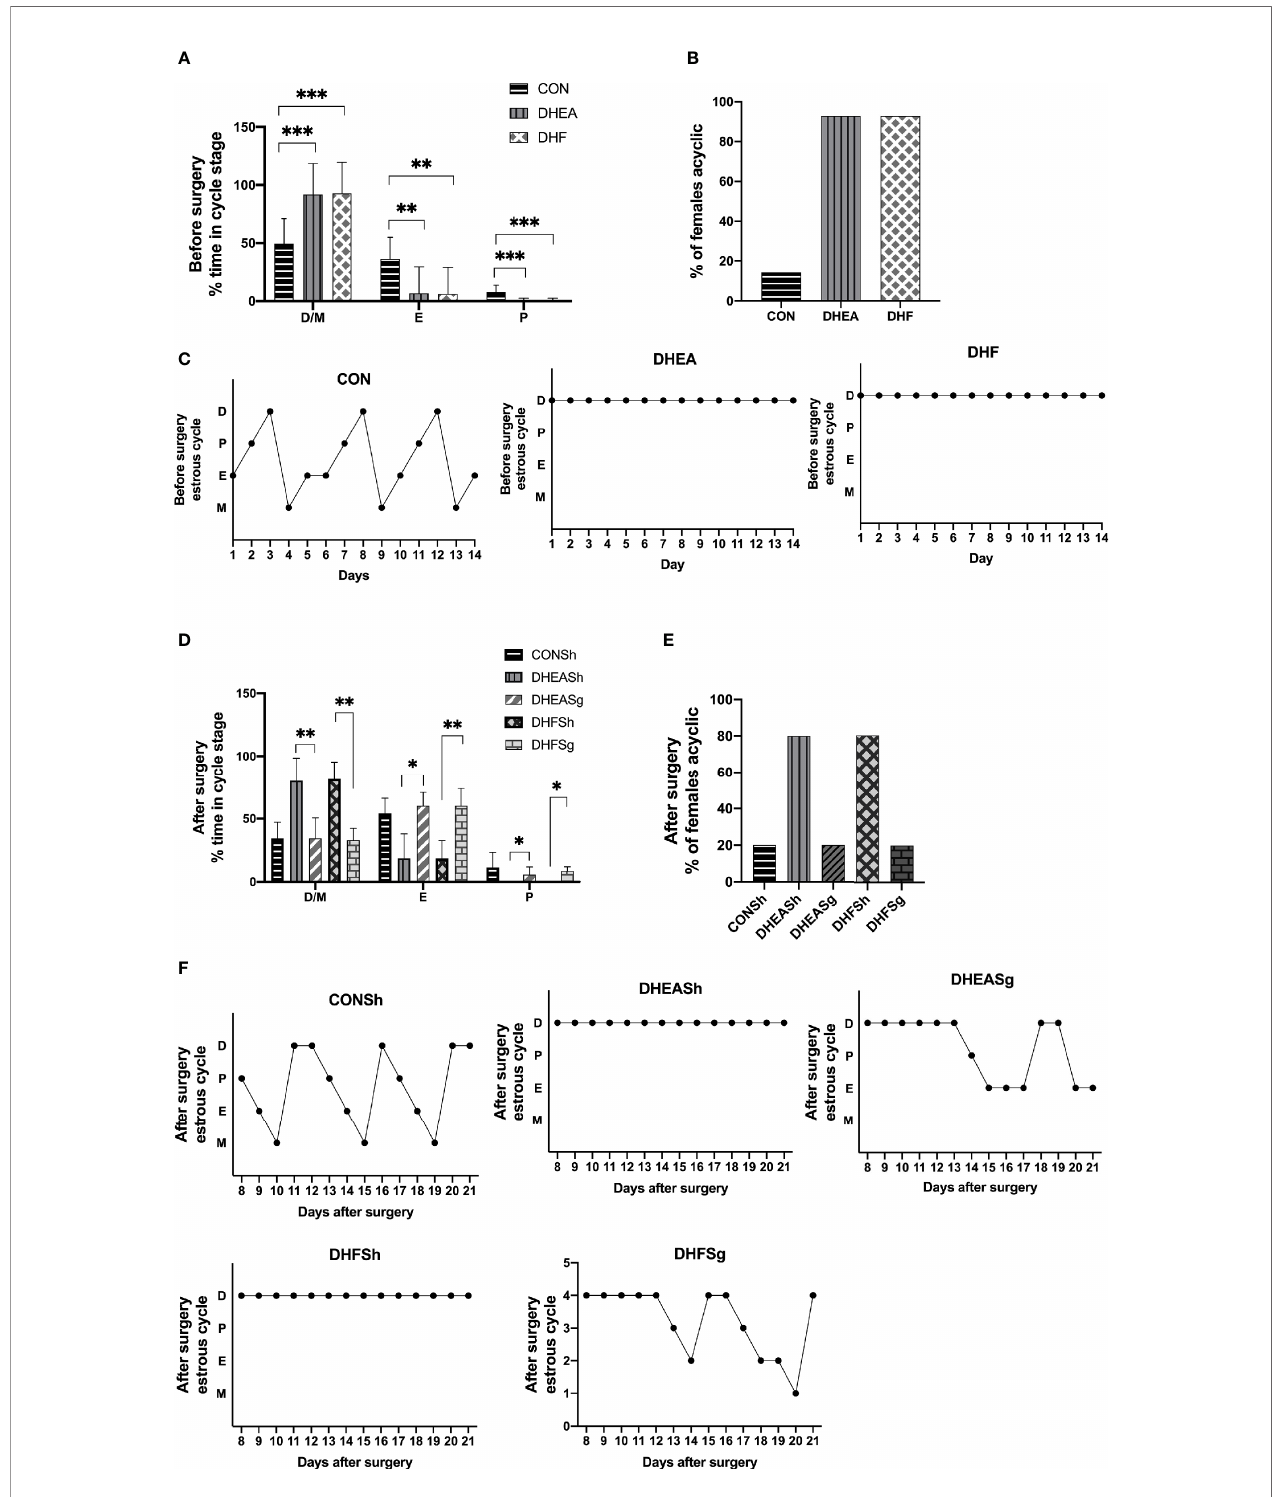
FIGURE 3 | Effects of sleeve gastrectomy on the estrus cycle. (A) Relative time span of each stage of the cycle pre-surgery. (B) The proportion of acyclic females (constant diestrus or constant estrus) pre-surgery. (C) Representative estrus cycles of different groups pre-surgery: 1, metestrus stage; 2, estrus stage; 3, proestrus stage; 4, diestrus stage. C-a: CON; C-b: DHEA; C-c: DHF. (D) Relative time span of each stage of the cycle post-surgery. (E) The proportion of acyclic females (constant diestrus or estrus) post-surgery. (F) Representative estrus cycles of different groups post-surgery. F-a: CONSh; F-b: DHEASh; F-c: DHEASg; F-d: DHFSh; F-e: DHFSg. *p < 0.05. **p < 0.01. ***p <